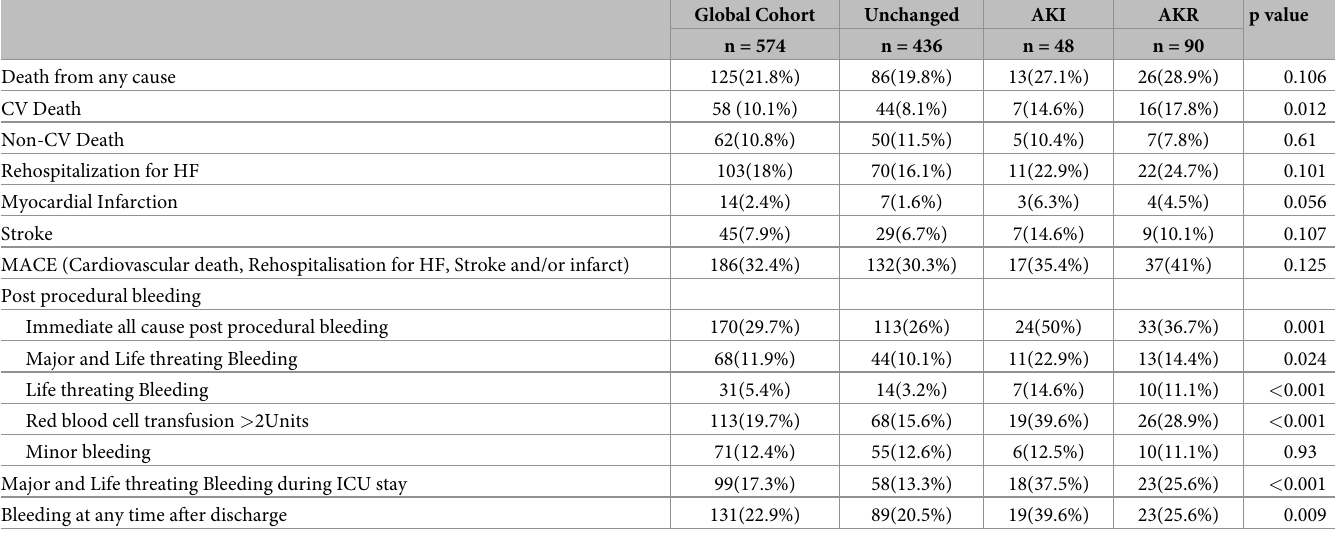
Table 4. Impact of Acute kidney injury and recovery on all-cause mortality and cardiovascular